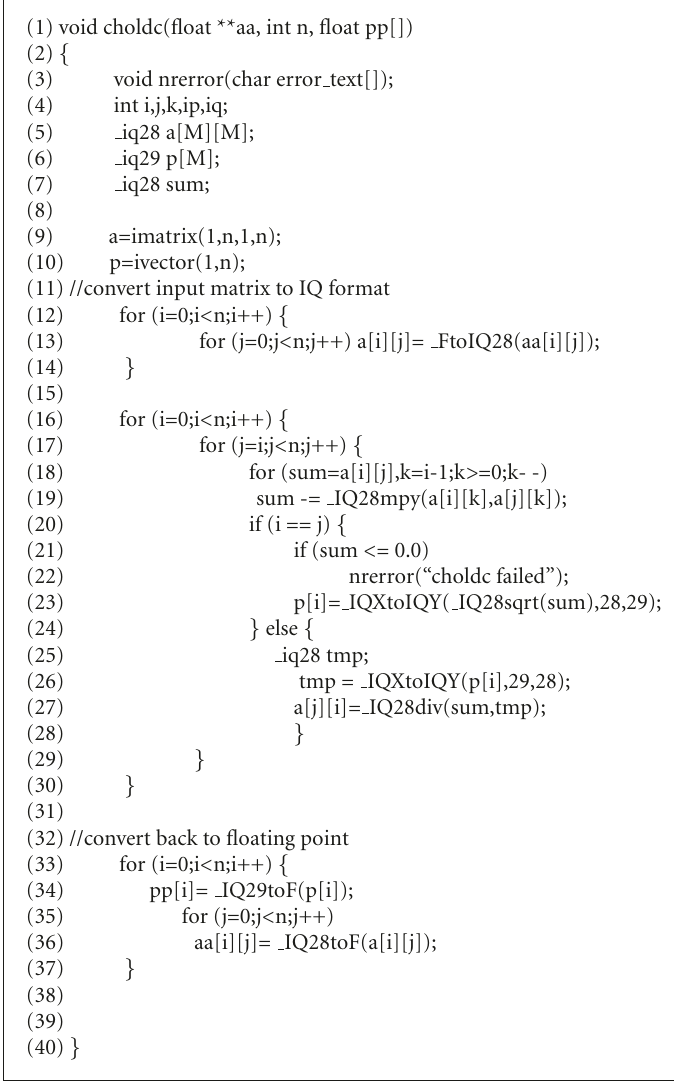
Figure 10: Fixed point implementation of Cholesky decomposition algorithm in